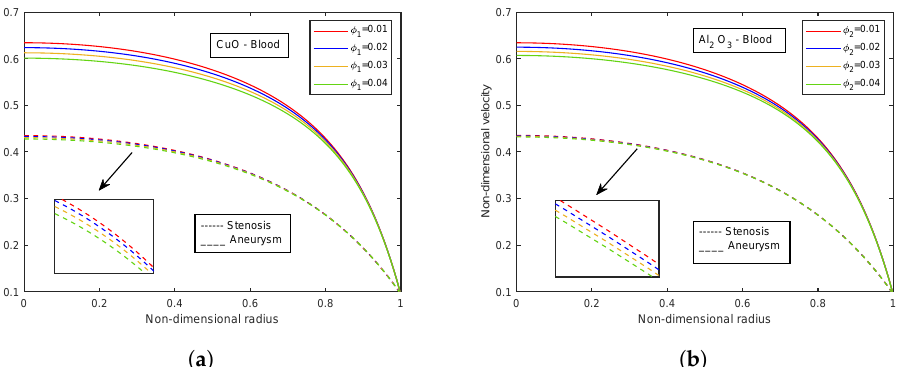
Figure 22. Influence of volume fraction of ( a ) CuO-nanoparticles, ( b ) Al 2 O 3 -nanoparticles on veloc- ity